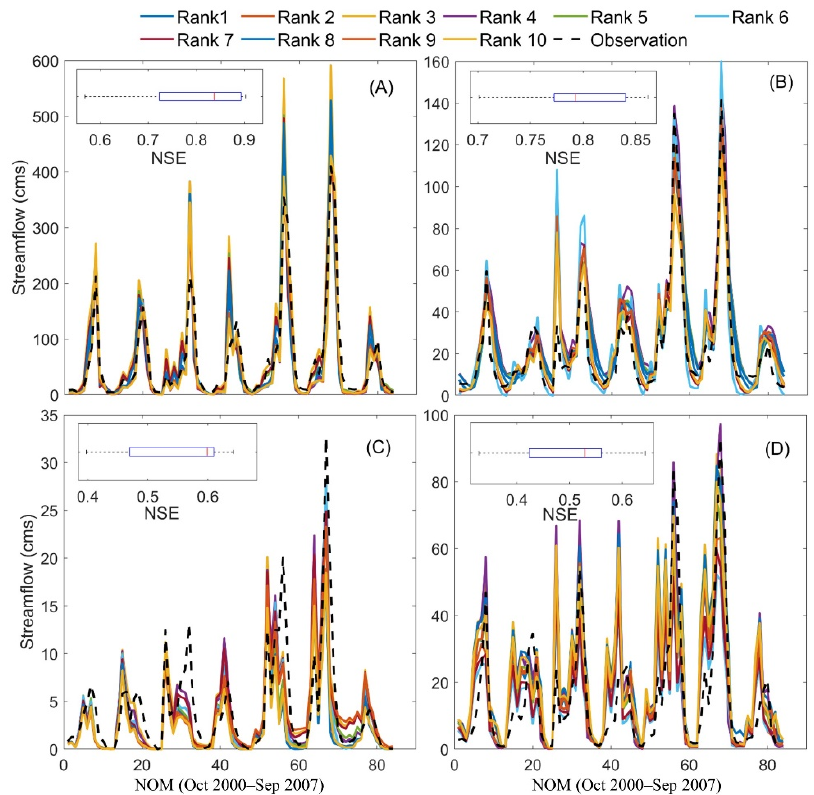
Figure 7. Monthly streamflow predictions based on the best 10 sets of parameters from the calibrations in stage 1 in the S3 scenario, and reference flow data during 2001–2007 (snow parameters are fixed with the calibrated values from S3 stage 2 for all 10 simulations). Distribution of NSEs (in the small plots) show that range of simulation performances when evaluated with the reference streamflow data. ( A – D ) The Kings, Kern, Tule, and Kaweah watersheds, respectively. NSE refers to the Nash-Sutcliffe Efficiency, and NOM refers to the Number of Months.